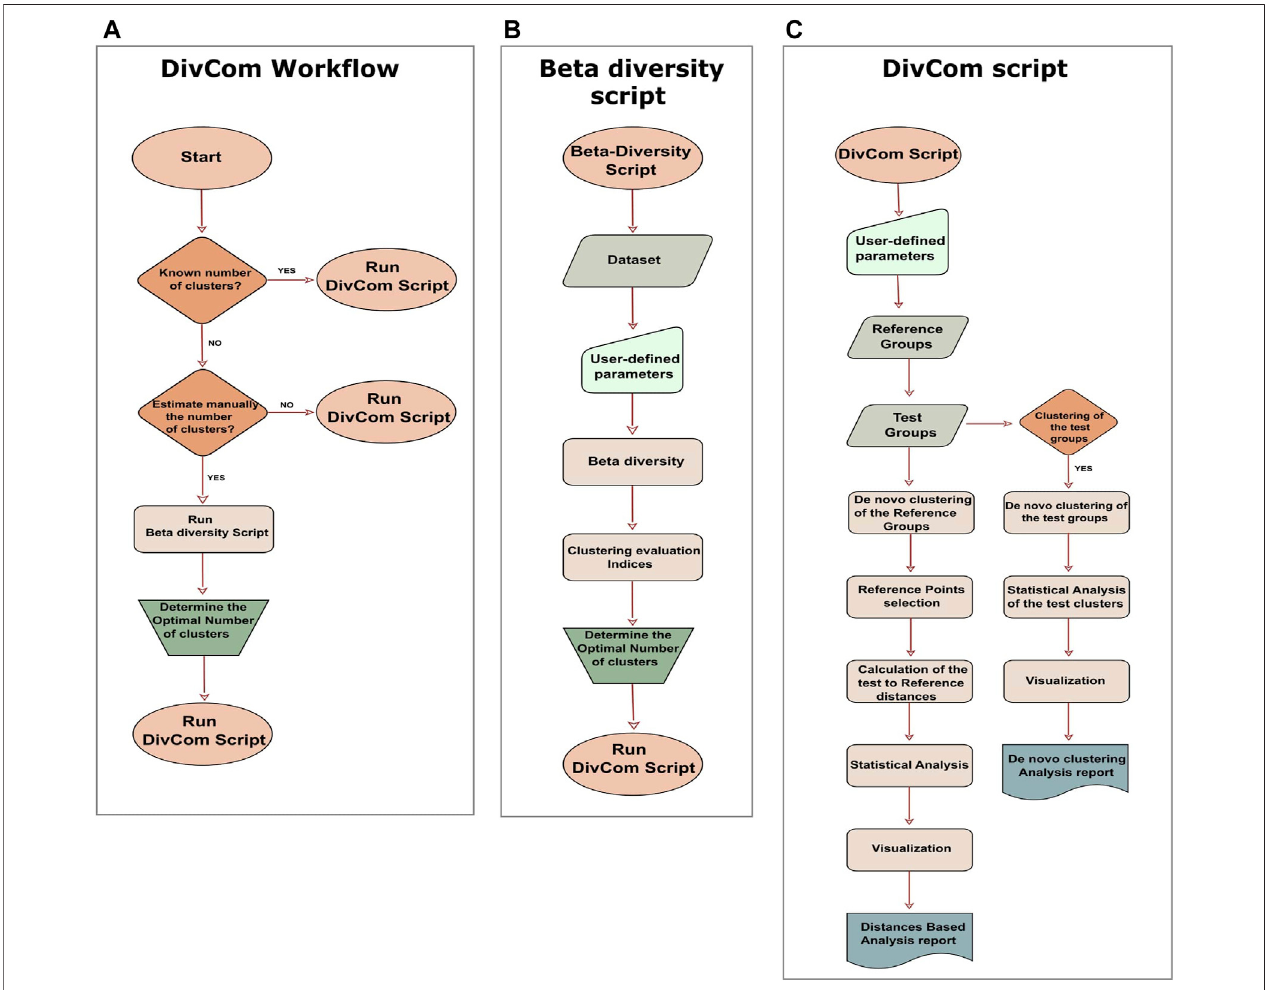
FIGURE2| Work fl owoftheDivComtool,andthetwoscriptsoftheprogram. (A) Accordingtothework fl owoftheDivCom, theusercanexecutethebeta-diversity to calculate the optimal number of clusters or to directly run the DivCom script. (B) The script “ Beta-Diversity.R ” calculates and visualizes beta diversity between the samples and produces the plots of four different clustering evaluation indices (Calinski-Harabasz, silhouette, prediction strength, and Within Sum of Squares). These outputs provide the user with the necessary information in order to determine the optimal number of clusters for each group. (C) The main script is called “ DivCom.R ” and performs de novo clustering to both the reference and test groups, calculates the pairwise distances of the reference and test samples, and fi nally conductsanautomatedstatisticalanalysisandproducesthe fi nalreports.Thisinformationcontributestoabetterunderstandingoftheinterrelationbetweenthedifferent groups under